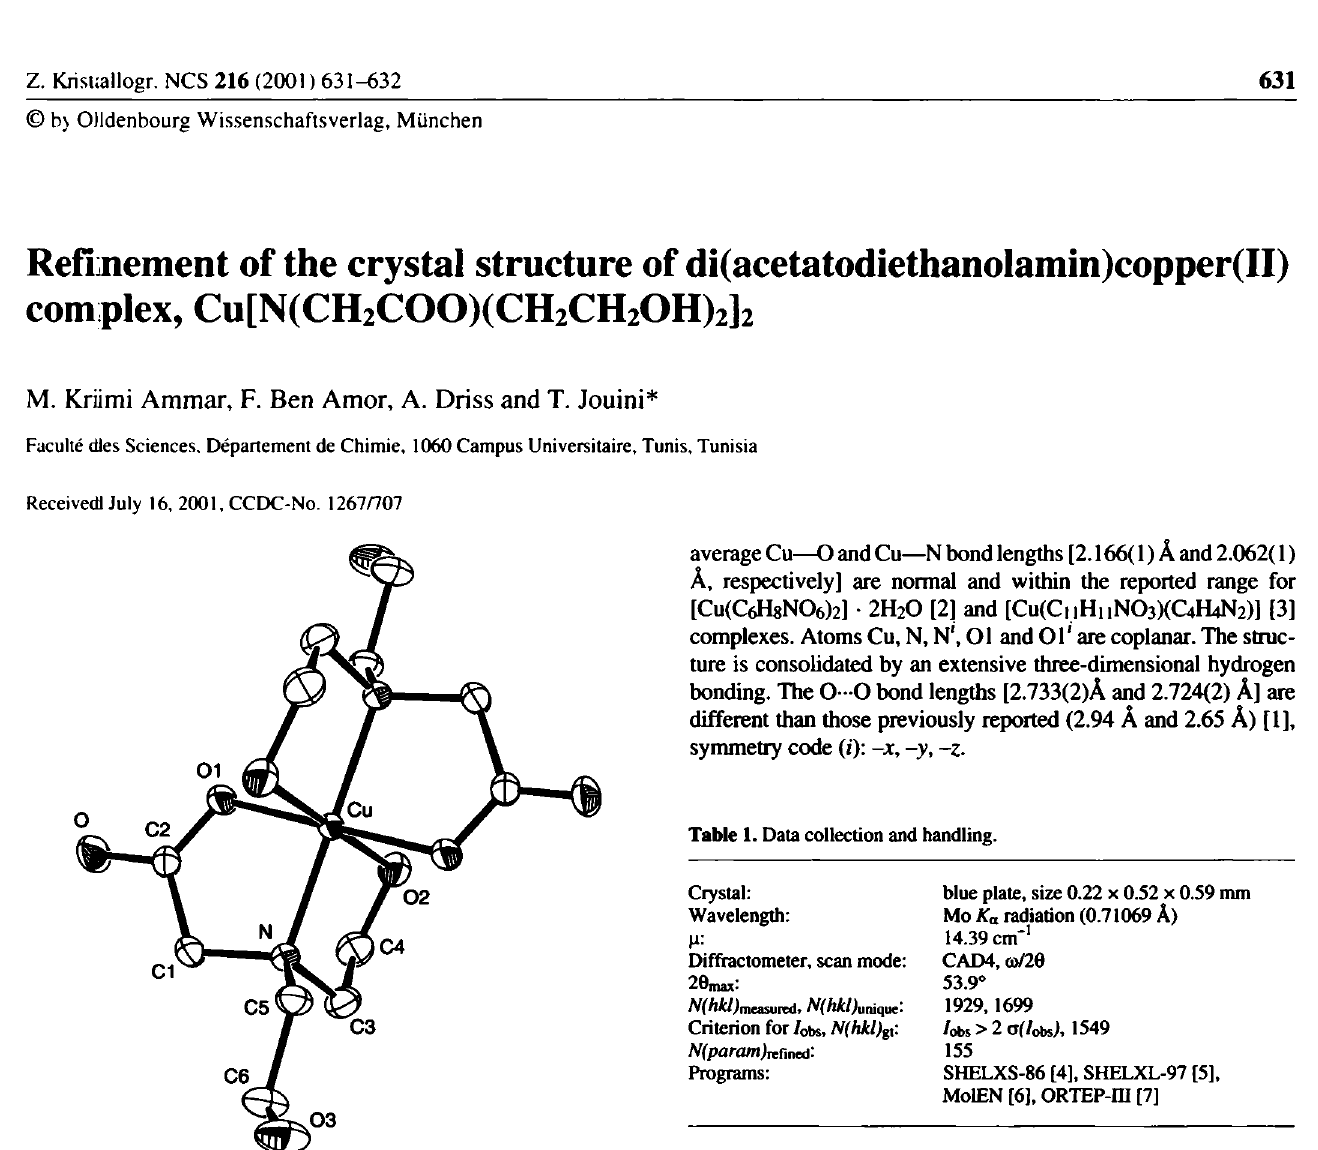
Table 2. Atomic coordinates and displacement parameters (in A 2